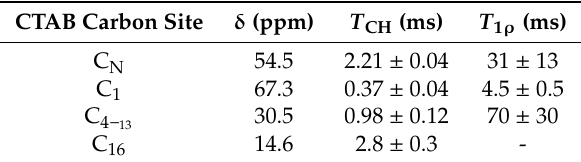
Table 2. Values of T CH and T 1 ρ for the selected CTAB spectral lines in MOR-AS derived from 1 H- 13 C CP / MAS NMR measurements.